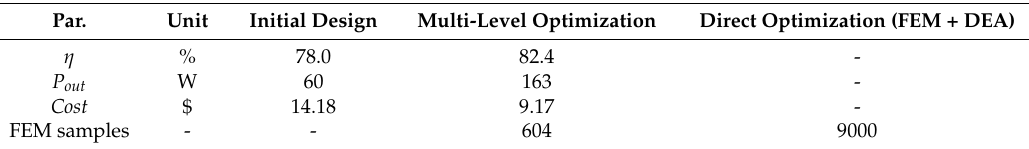
Table 5. Optimization results of the CPM.